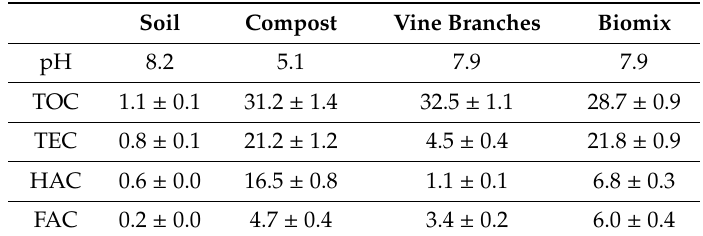
Table 1. pH (H 2 O) and organic carbon content (%) of soil, organic wastes and biomix used in the experiment (mean of three replicates ± standard